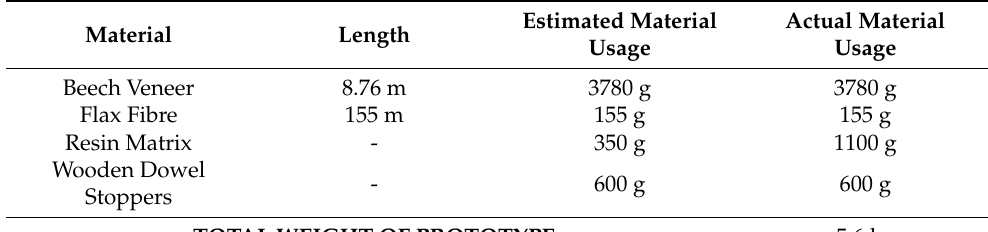
Table 1. Materials used and resulting weight for the final prototype.